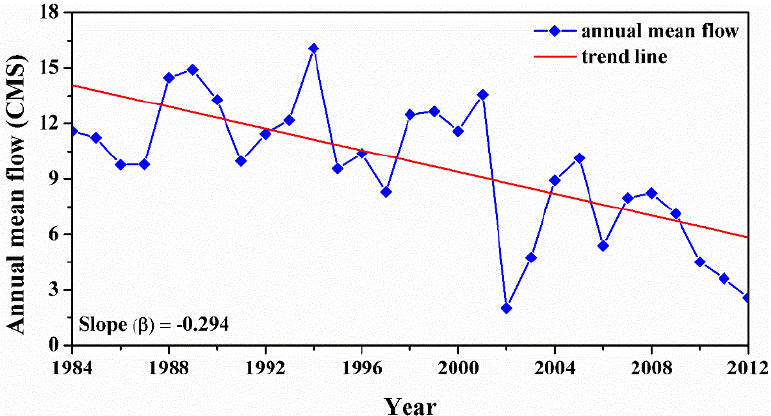
Figure 3. Time series plots for the annual mean flow at the Ximen Bridge Station. The straight red line shows the trend